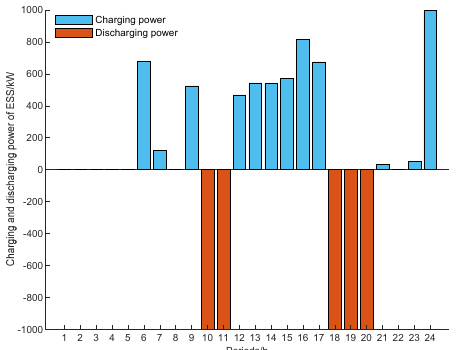
Figure 5. Wind turbine output power.